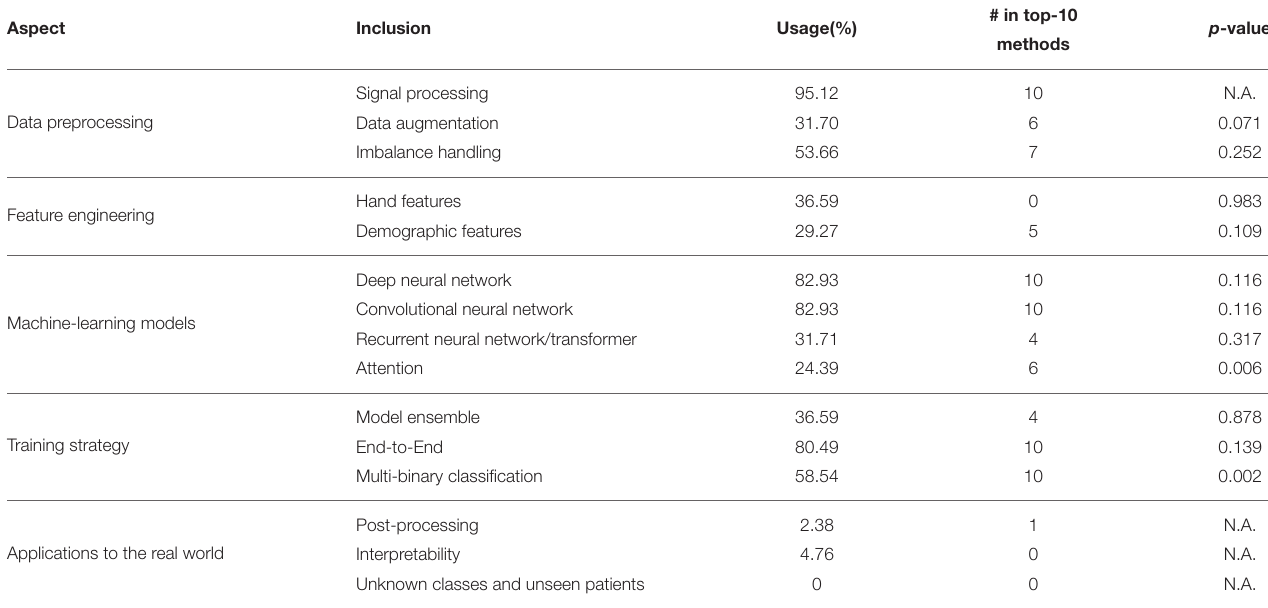
TABLE 2 | Details of employed